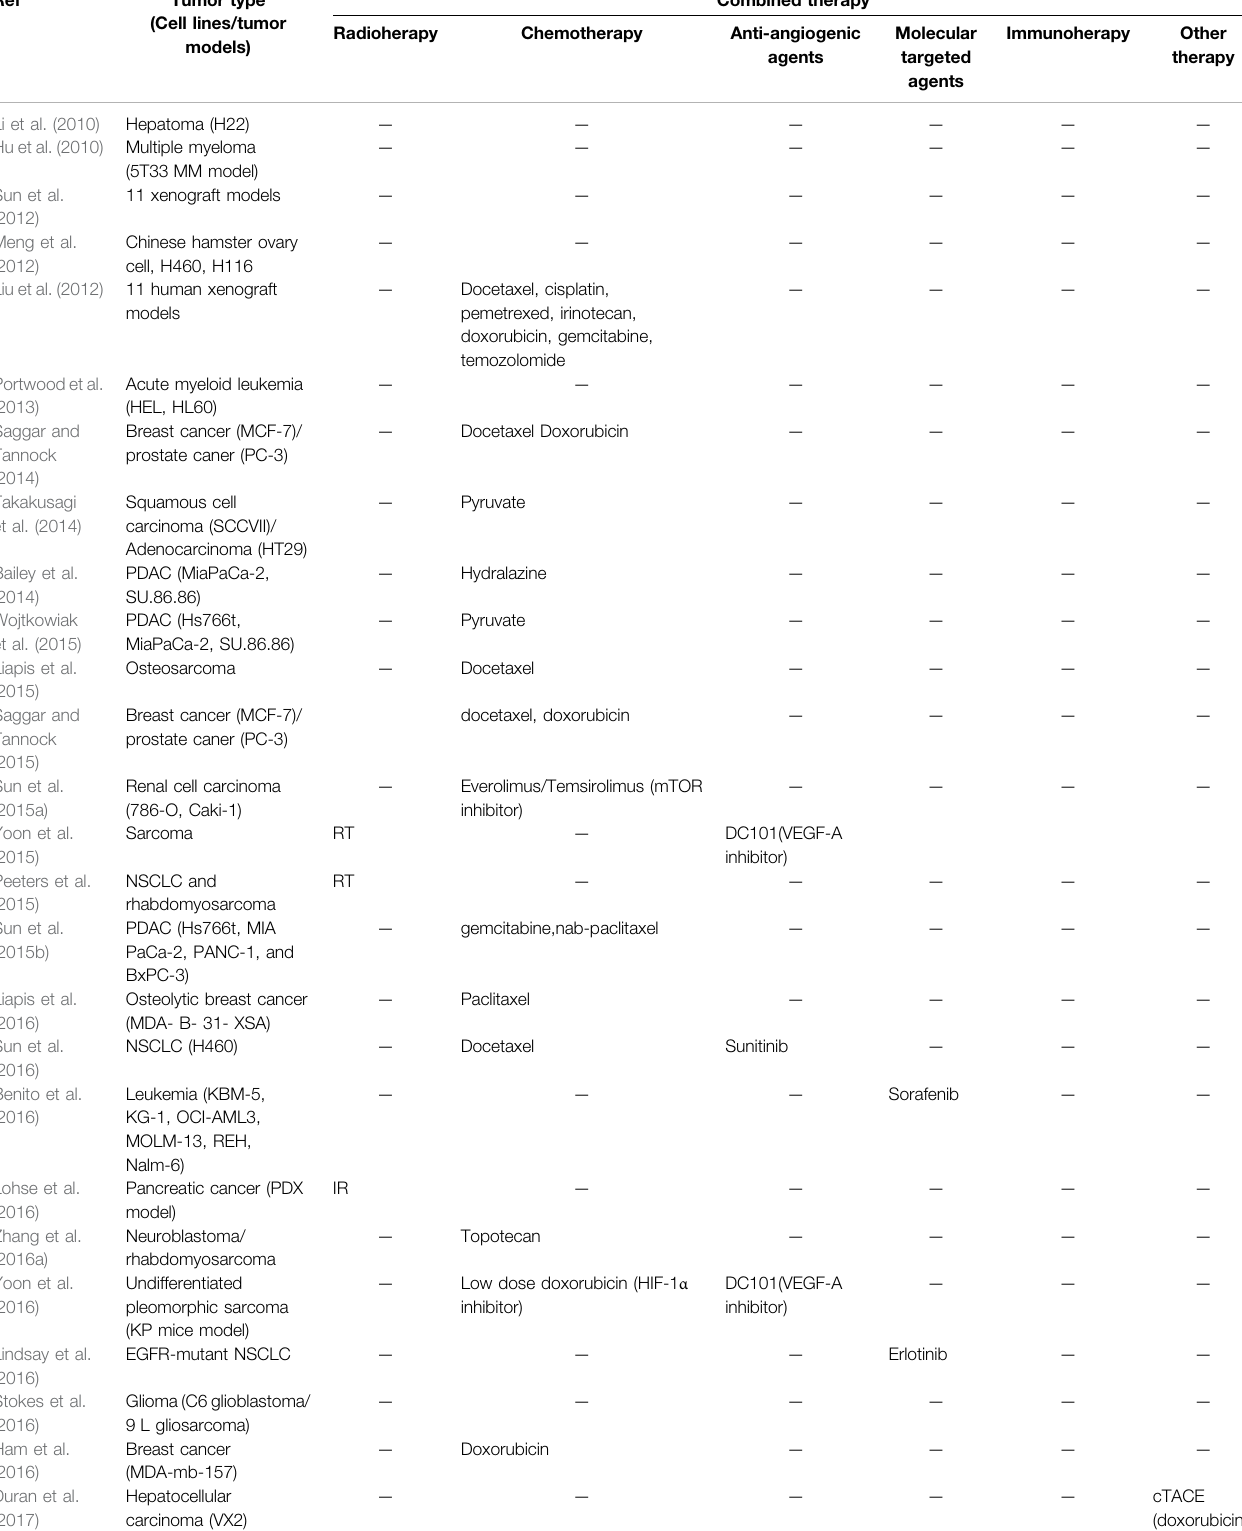
TABLE 1 | Pre-clinical studies of